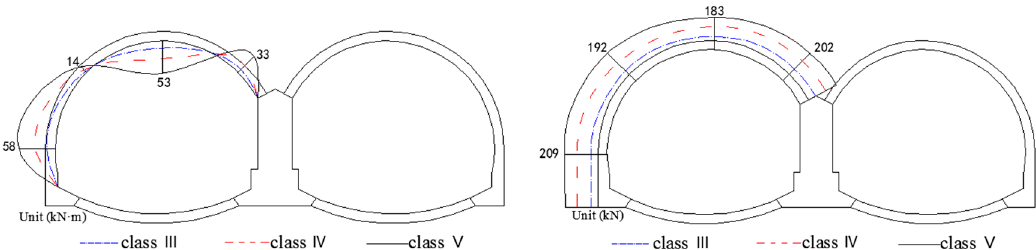
Figure 24. Final distribution of the internal forces in secondary linings in the cross sections corresponding to three different classes of rock masses (class III, IV and V respectively).